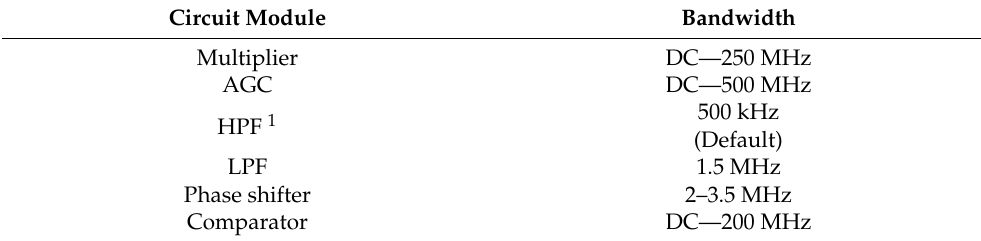
Figure 11. Block diagram of the experimental interpolation circuit. Table 3. Bandwidth of the circuit module in the experiment.